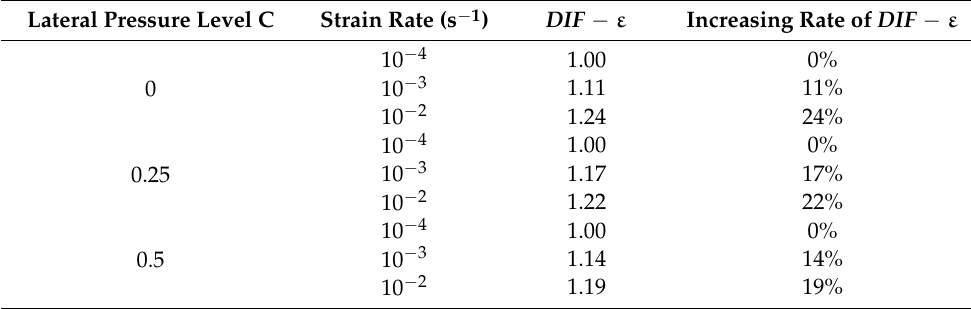
Figure 7. The relationship between peak strain and strain rate under different lateral pressure levels. (1) Dynamic strain growth factor DIF − ε For evaluating the strain rate sensitivity of a material’s strain, the dynamic strain growth factor DIF − ε value is generally used for research [21]. The calculation method of DIF − ε is: ε 1 DIF − ε = (6) ε 0 In Equation (6), ε 1 signifies the dynamic peak strain at different lateral pressures and strain rates, and ε 0 represents the static peak strain at different lateral pressure levels (C = 0, 0.25, 0.5). The uniaxial peak strain under a strain rate of 10 − 4 s − 1 is taken as the reference dynamic peak strain. The calculated results are shown in Table 8. Table 8. DIF − ε values of ECC under different lateral pressure